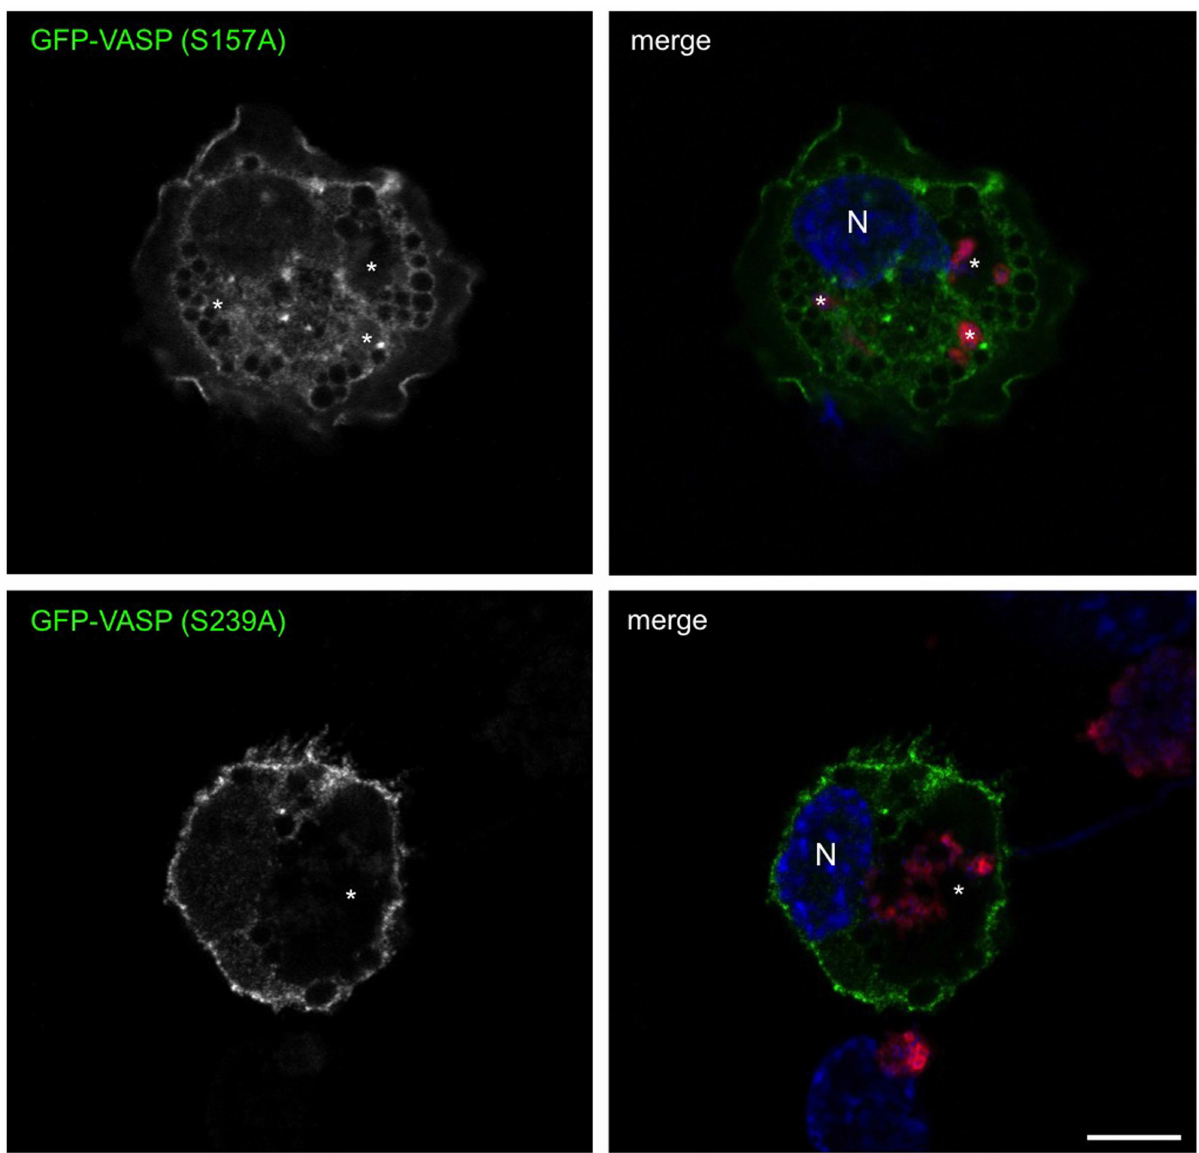
Fig 9. VASP (S157A) expression prevents typical PV formation. THP-1 cells were transfected with constructs encodingGFP-VASP (S157A) or GFP-VASP (S239A). At 72 hpi with C. burnetii (red), cells were processed for fluorescence microscopy and DNA was stained with DAPI (blue). Bar, 10 μ m. N = nucleus and * indicates the PV. Results are representative of at least three separate experiments. GFP-VASP (S239A) expression allowedtypical PV expansion, while GFP-VASP (S157A) expressioninterfered with vacuole expansion, indicatingphosphorylation of S157 is critical for PV